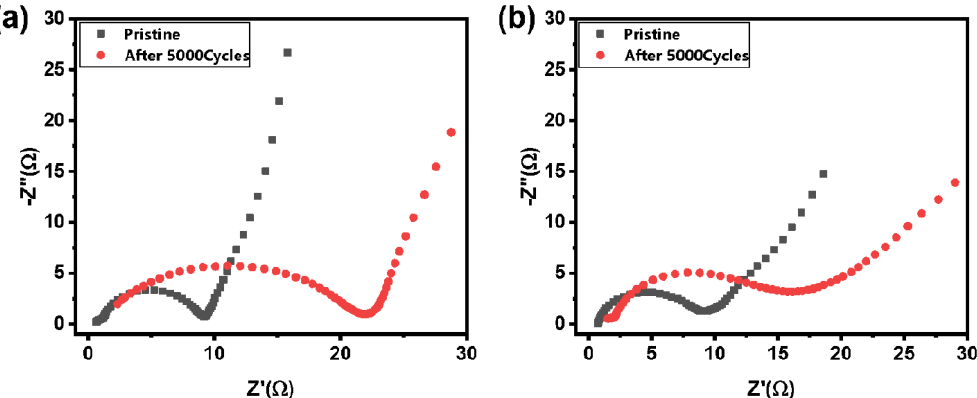
Figure 10. Impedance behavior of AC-based EDLC cells with different ZnO coating schemes ( a ) 20-cycle ZnO ALD coated on AC electrodes; ( b ) 20-cycle ZnO ALD coated on AC powders. Table 2. Impedance comparison among various AC electrode